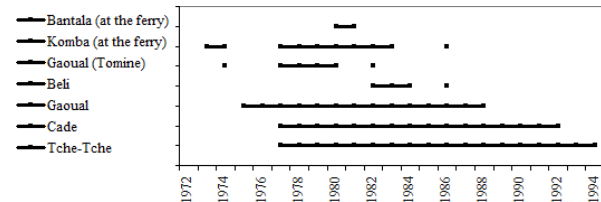
Figure 3. Chronogram of available discharge according to the sta-